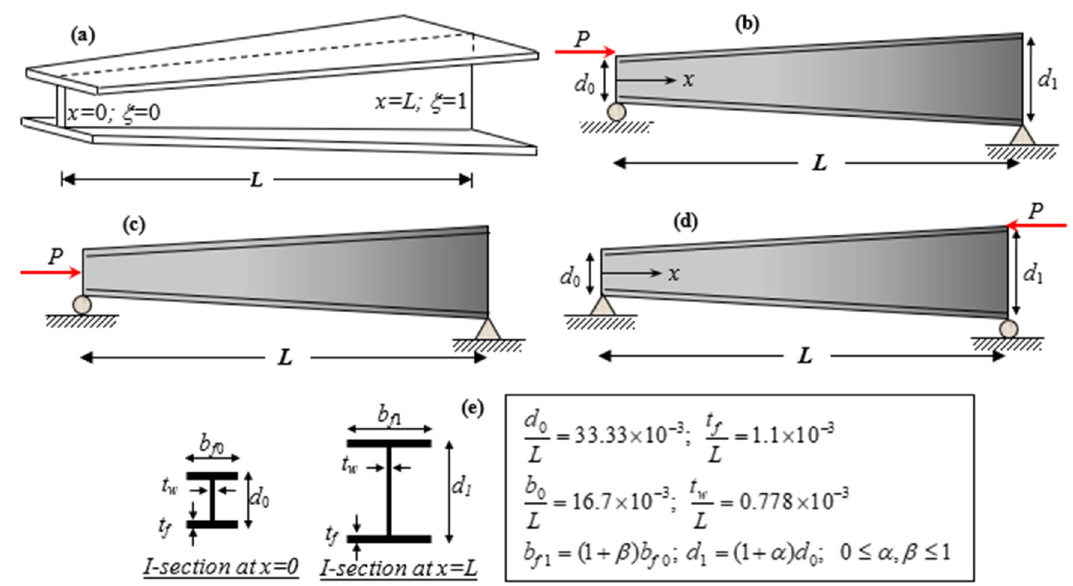
Figure 2. ( a ) Schematic representation of double-tapered beam with I-sections. ( b ) Axial load on the TF at x = 0 ( c ) Axial load on the centroid. ( d ) Axial load on the TF at x = L ( e ) Geometrical properties.